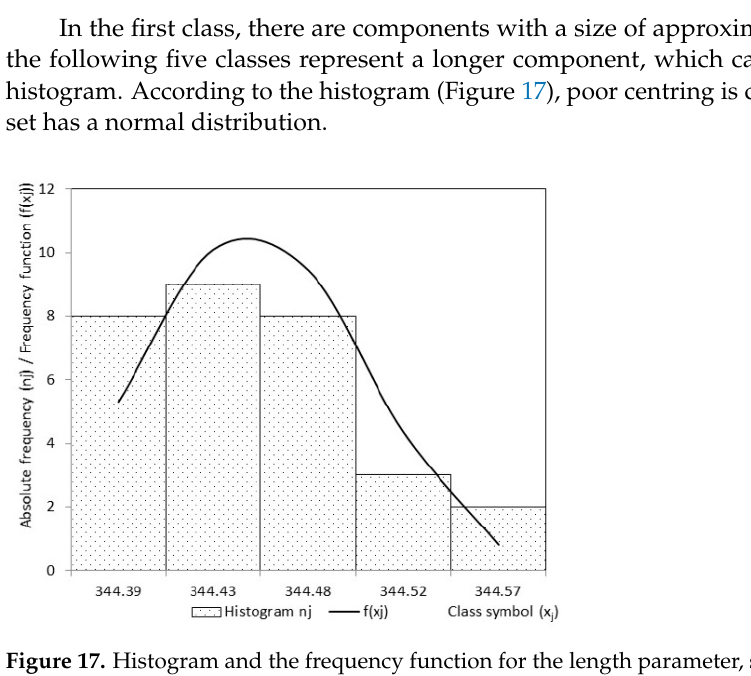
Figure 16. Measured data for the length parameter, second day [20].